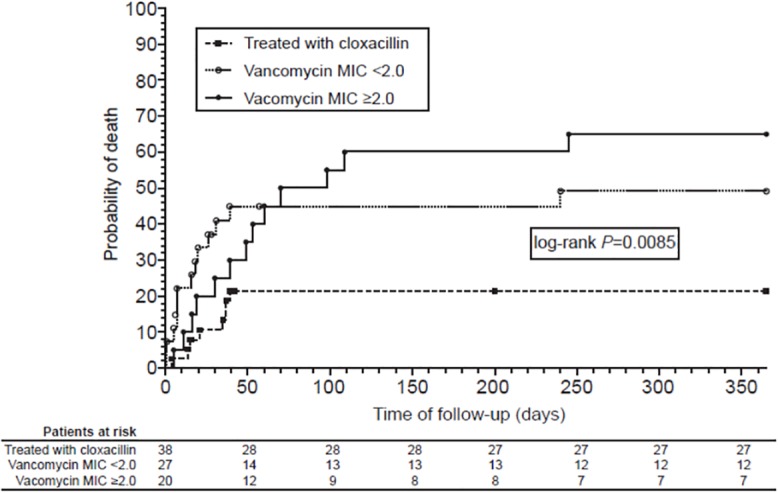
One-year survival analysis according to antibiotic therapy and vancomycin MIC.One-year survival analysis of 85 patients with coagulase-negative staphylococci infective endocarditis according to the treatment received and vancomycin minimum inhibitory concentration (MIC).